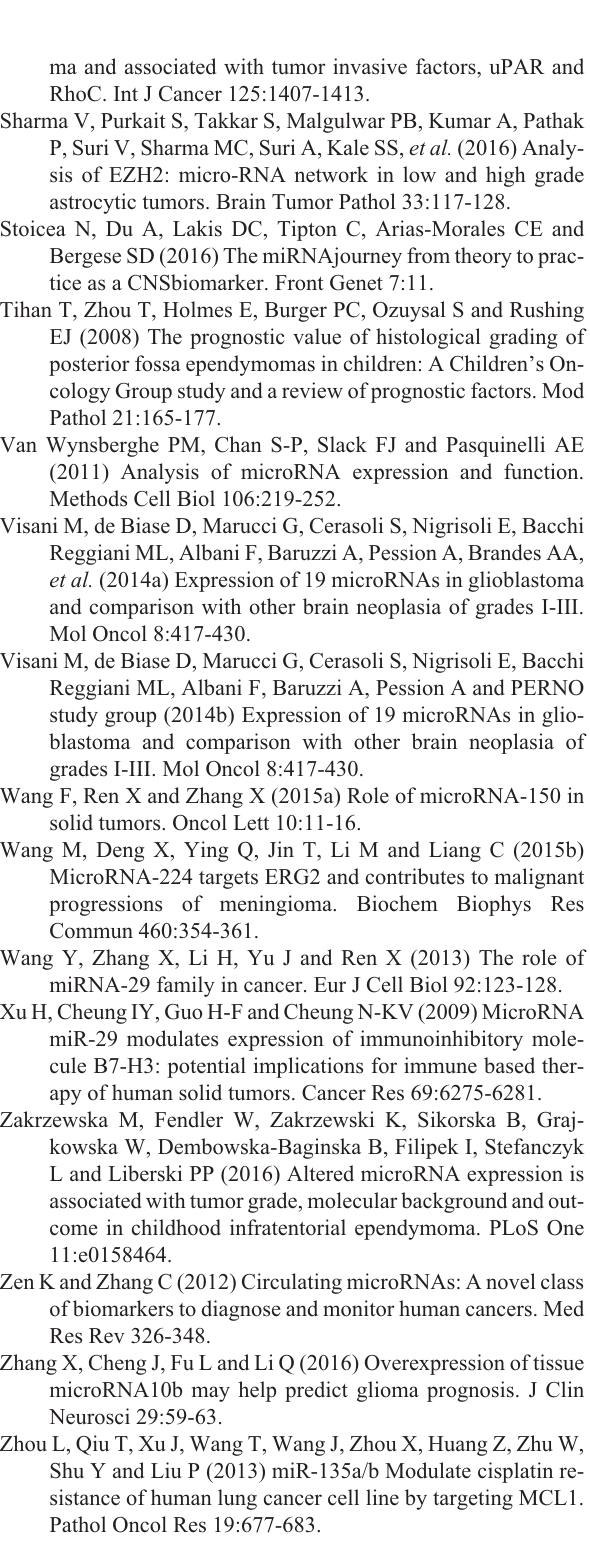
Table S1 – List of miRNA sequences used in this study. Table S2 – dCT values of differently expressed miRNAs in MED compared to other subtypes (EPN, LGG, and